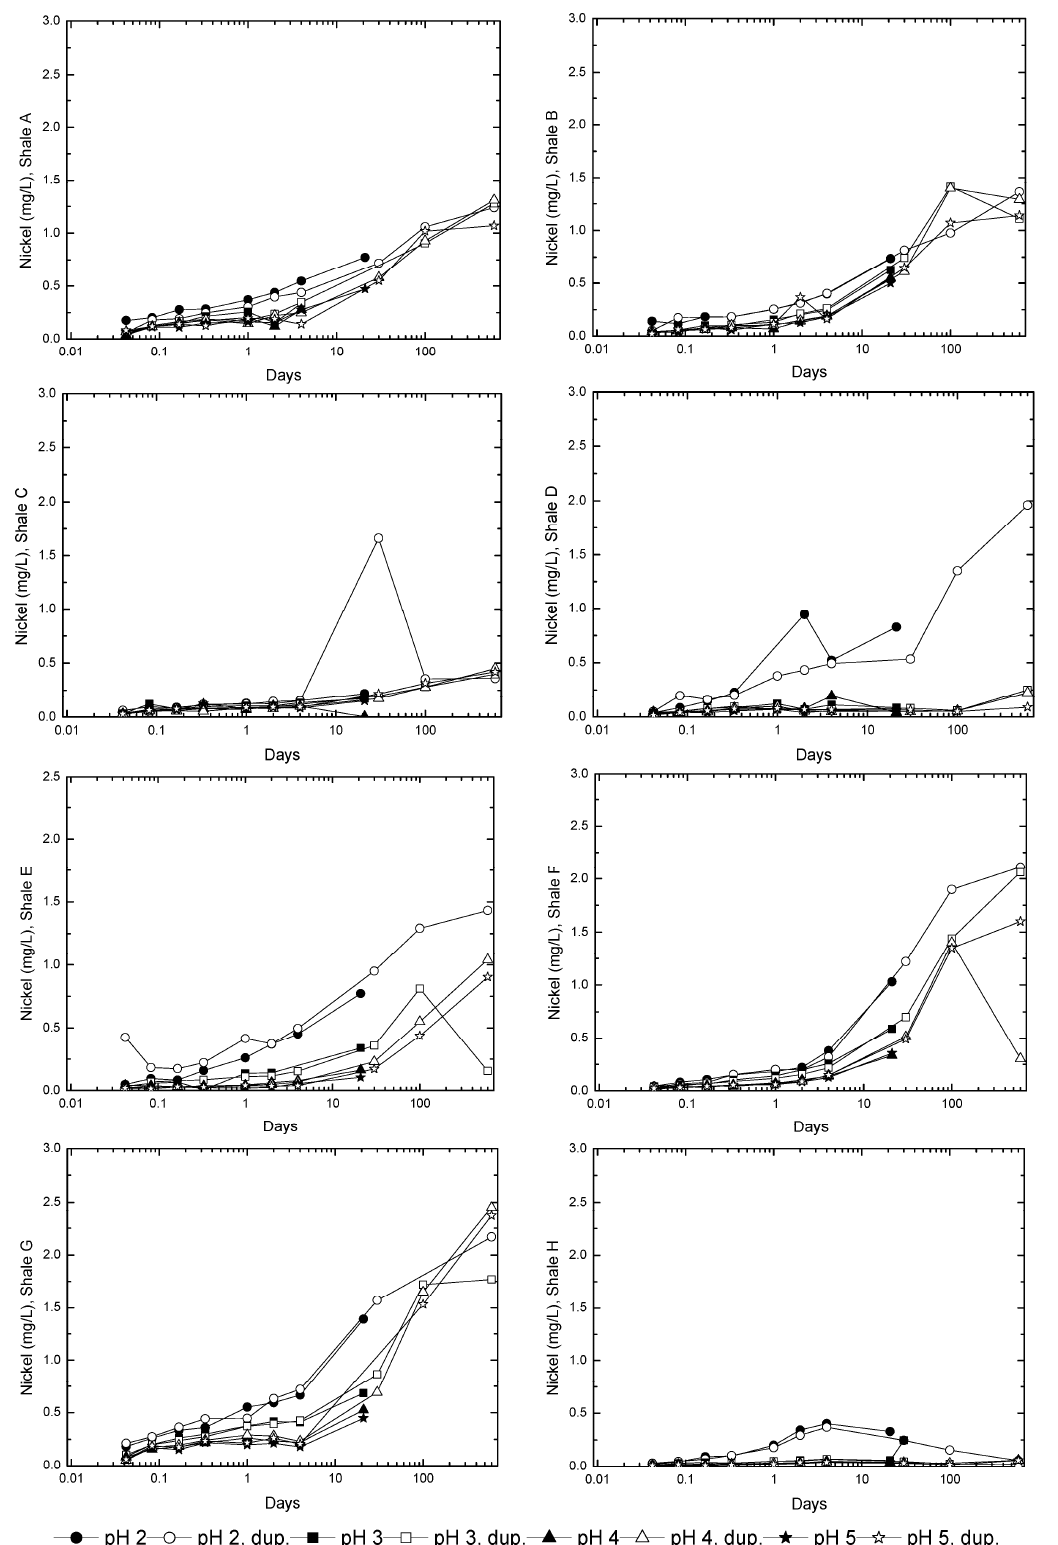
Figure 5. Solution Nickel concentration recorded over time for all reaction vessels for all samples. Points on lines mark sample intervals from experiment commencement and 1, 2, 3, and 8 h, and 1, 2, 4, 21, 30, 100 and 600 days (logarithmic scale). The legend indicates initial sample